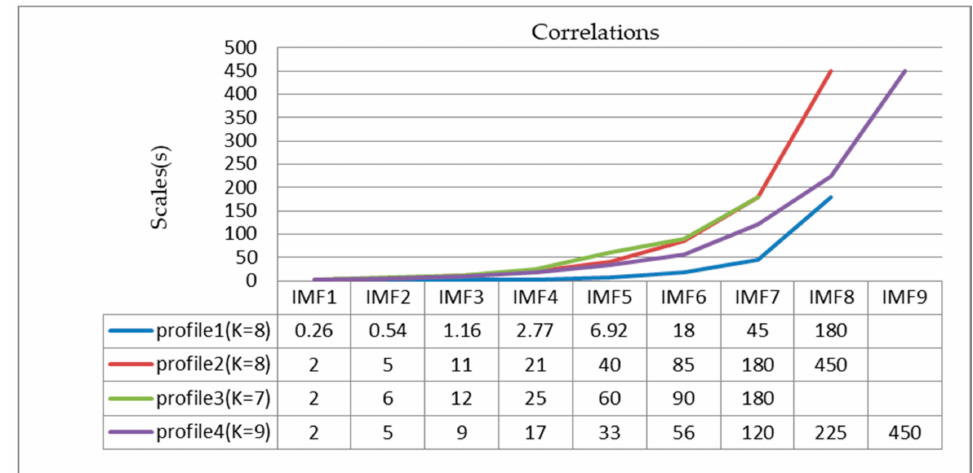
Figure 7. The correlations between the time scales and the number of modes K for four